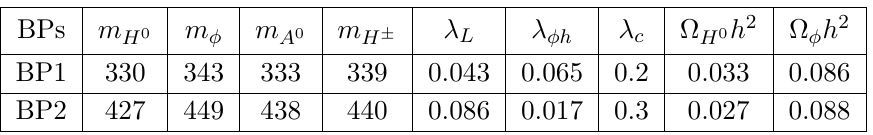
Table 2 . Benchmark points used to analyse EW vacuum stability in our model. All masses are in GeVs. The other couplings used in these benchmark points play an important role; they are: BP1: